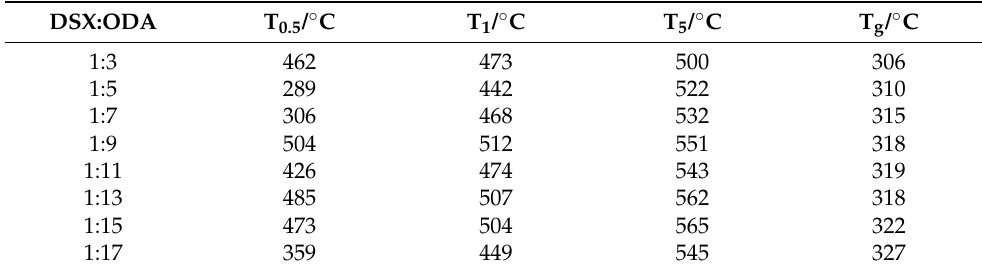
Table 2. Thermal data of PI films in group 1.